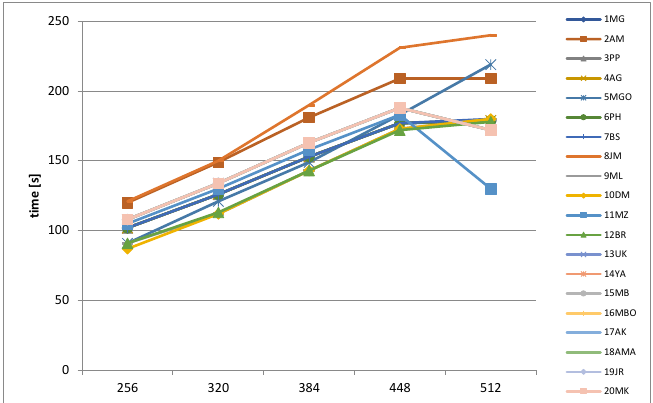
Figure 8. Acquisition times for all patients.